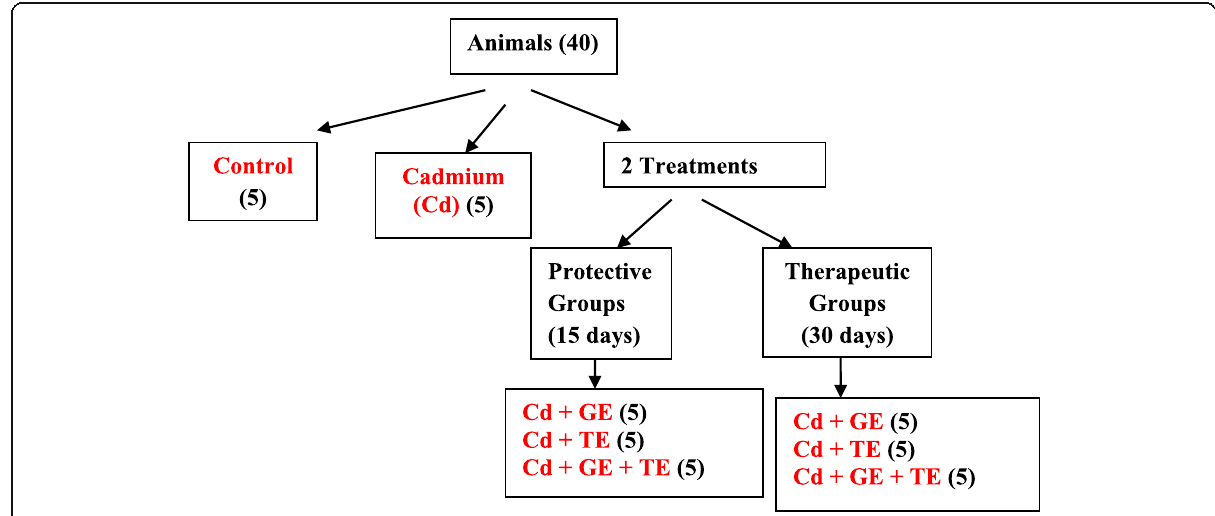
Fig. 1 Division of animals between different